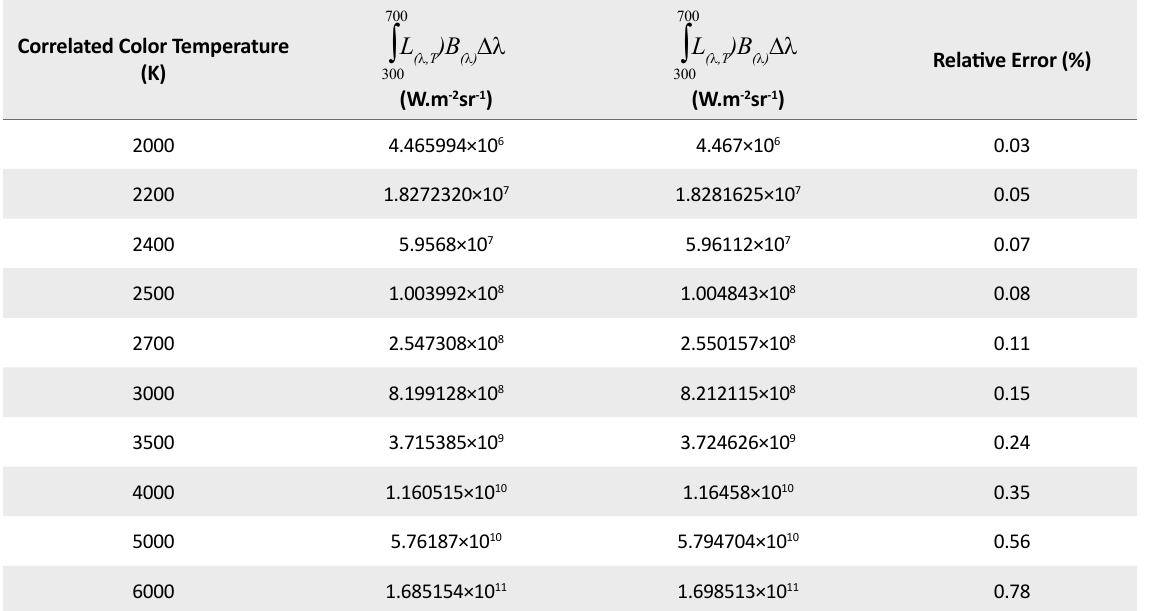
Table 2. The calculations of light energy with and without the non-photopic range of wavelength for different temperatures using originpro software